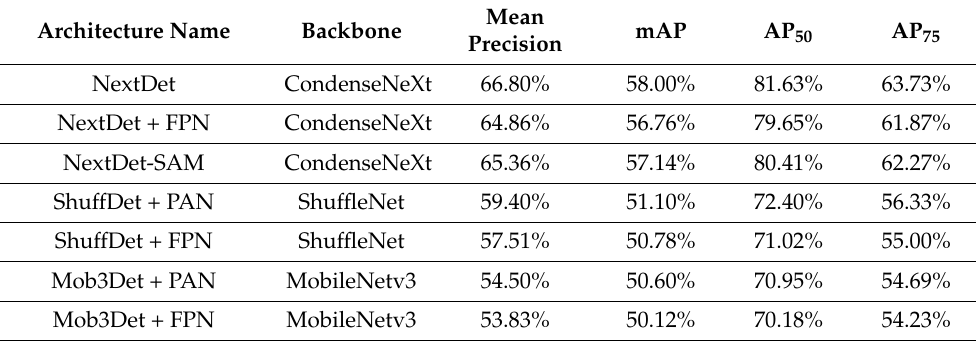
Table 3. A summary of performance comparison benchmarked on the Microsoft COCO dataset.